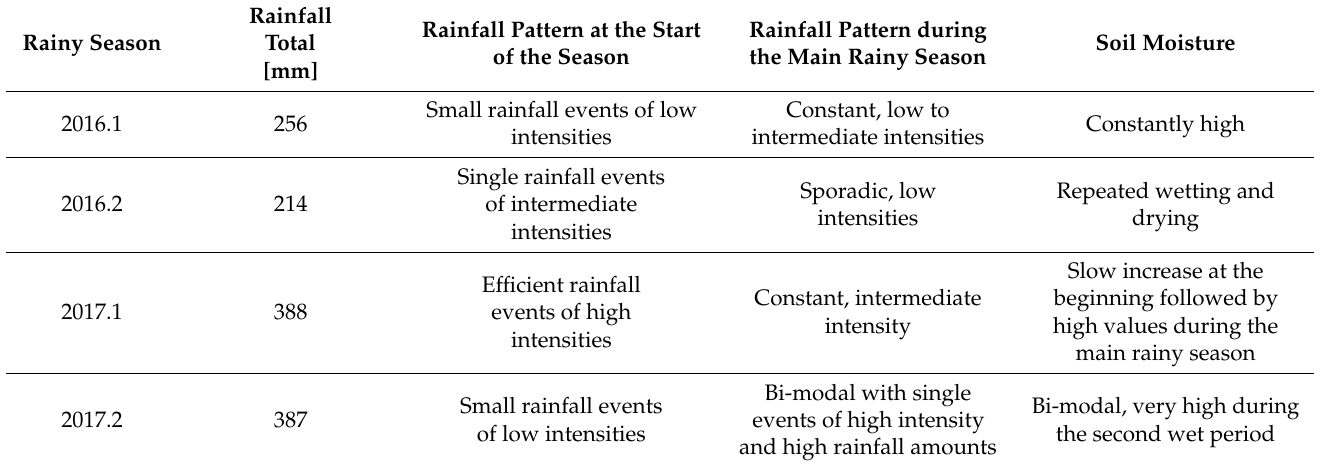
Table 2. Rainfall characteristics and main trends in the soil moisture dynamics during the four rainy seasons in 2016 and 2017.